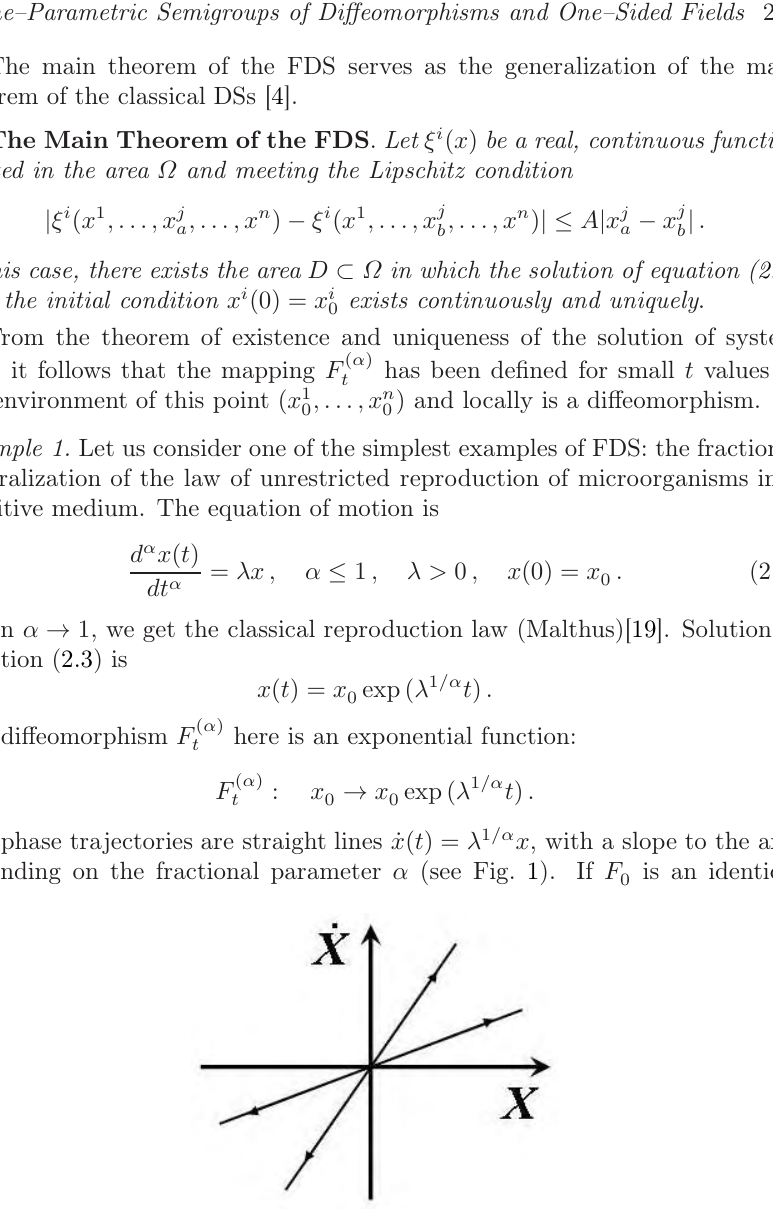
Figure 1. The vector field ξ = ( x,λ 1 /α x ) in Cartesian coordinates for various initial